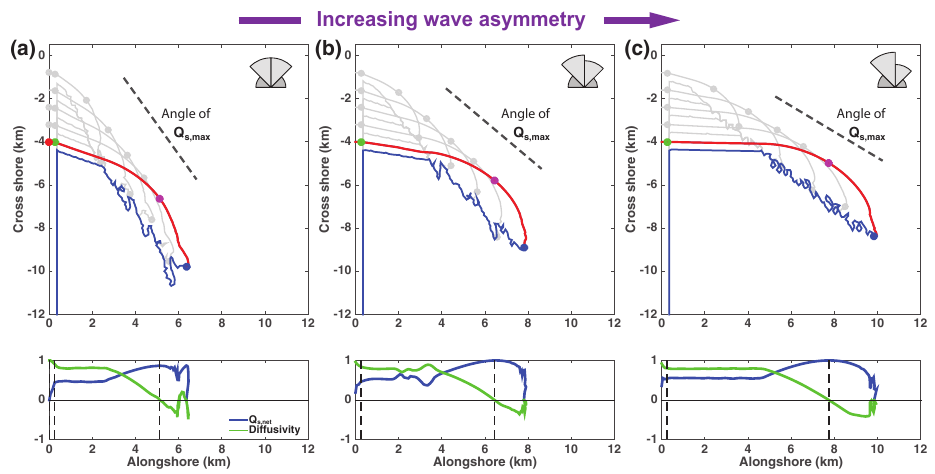
Figure 10. Plan views of modeled spits extending off of a headland eroding at a fixed rate of 0.08mday − 1 after 137 model years (with “ghost” shorelines every 27 model years) above plots of normalized sediment transport and diffusivity. The only difference between simula- tions is the wave asymmetry: (a) A = 0 . 5, (b) A = 0 . 6, and (c) A = 0 . 7 ( U = 0 . 2). Plot features explained further in Fig. 4 caption.